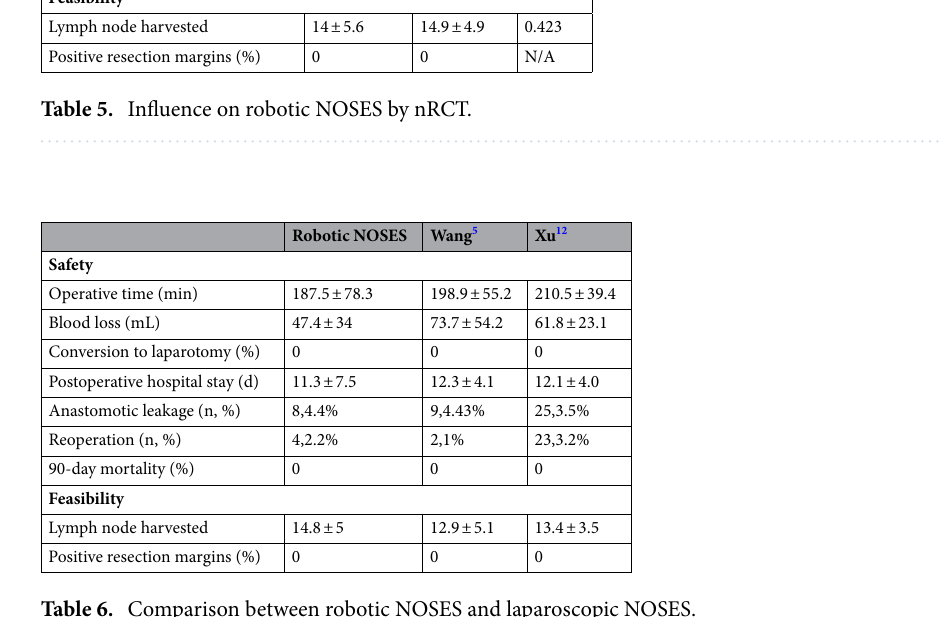
Table 6. Comparison between robotic NOSES and laparoscopic